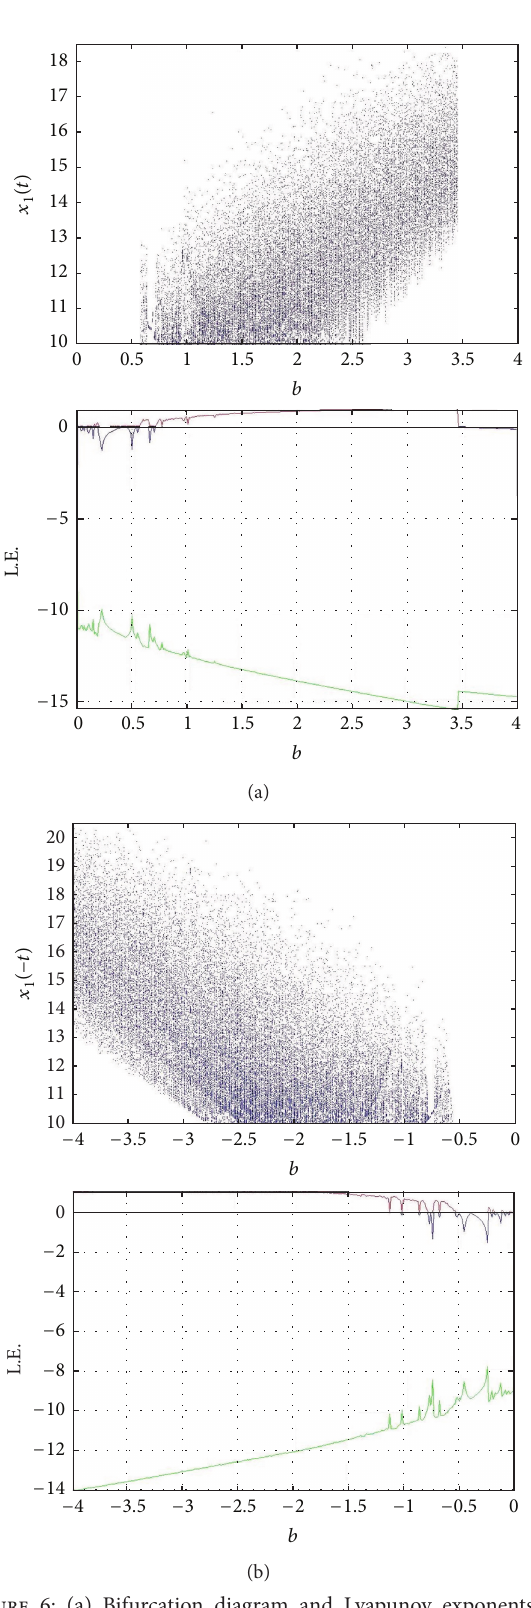
Figure 5: (a) Bifurcation diagram and Lyapunov exponents of chaotic classical Lorentz system with 𝑏 = 8/3 and 𝑎 = 10 . (b) Bifurcation diagram and Lyapunov exponents of chaotic time- reversedLorentzsystemwith 𝑏 = −8/3 and 𝑎 = −10 .Thetablesgiven previously show the different dynamic characters between classical and time-reversed Lorentz.